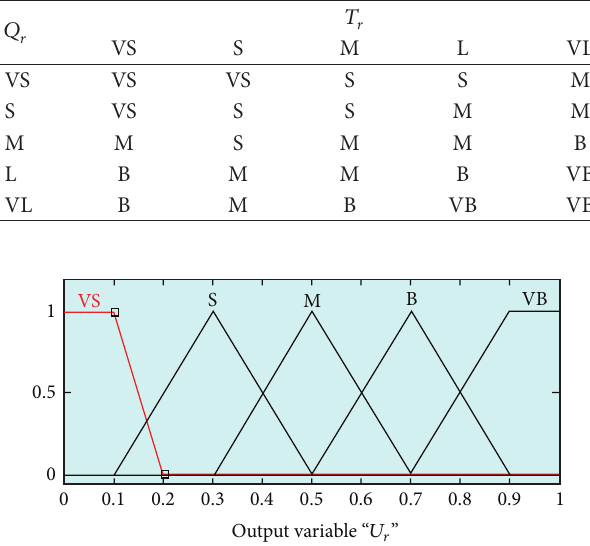
Figure 5: The membership function of input variable 𝑇 𝑟 .